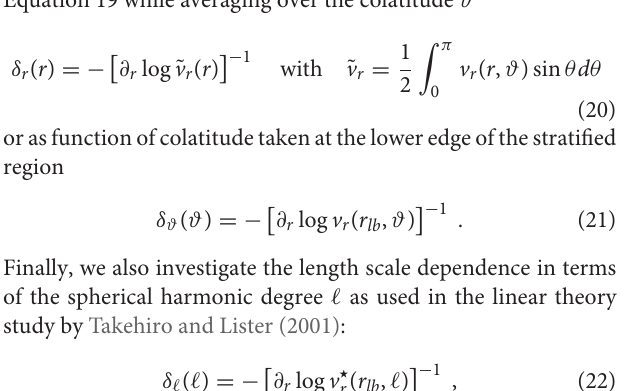
√ E . The gray shaded areas mark colatitude bands inside the tangent cylinder set by sin ϑ TC =